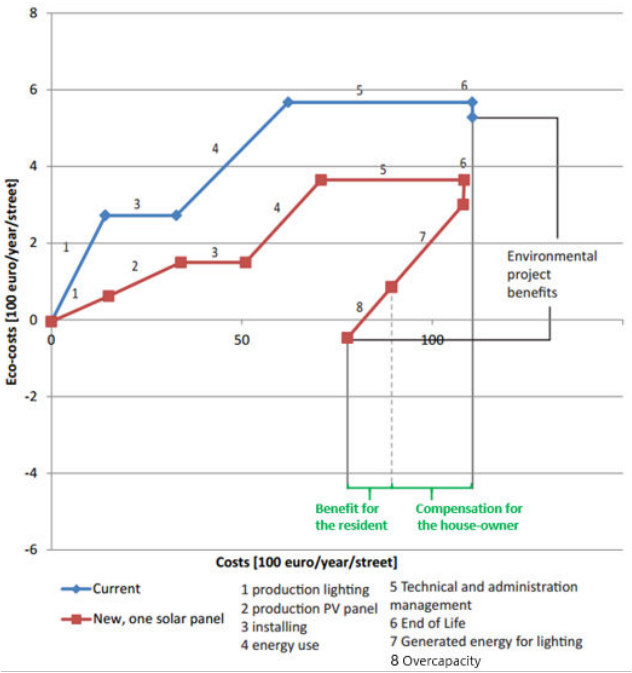
Figure 14. The rooftop lighting system, with one PV cell, compared to the base case.